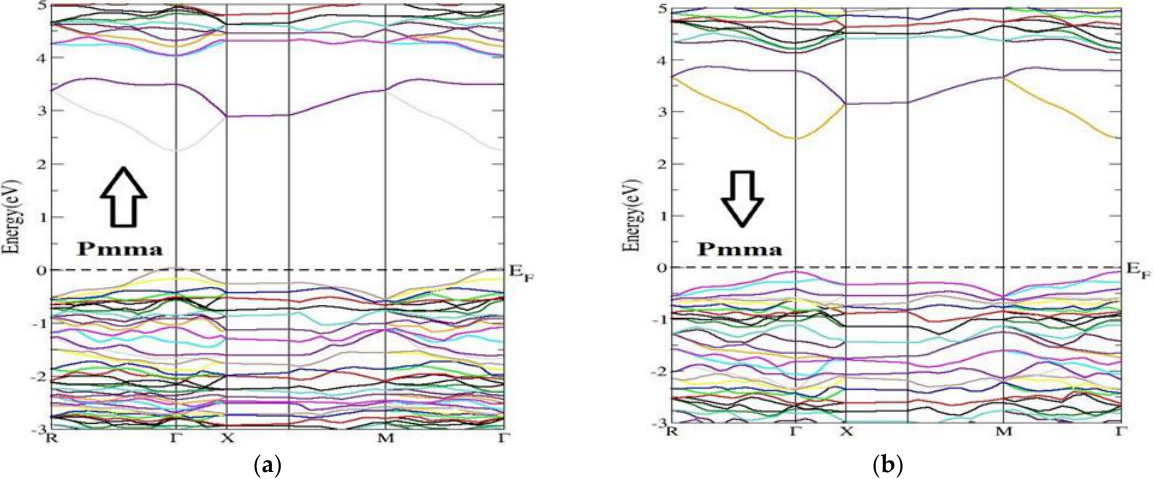
Figure 2. Energy band structure of Nd 2 Zr 2 O 7 compound in Fd-3m phase for ( a ) the spin-up direction ( ↑ ) and ( b ) spin-down ( ↓ ) direction.